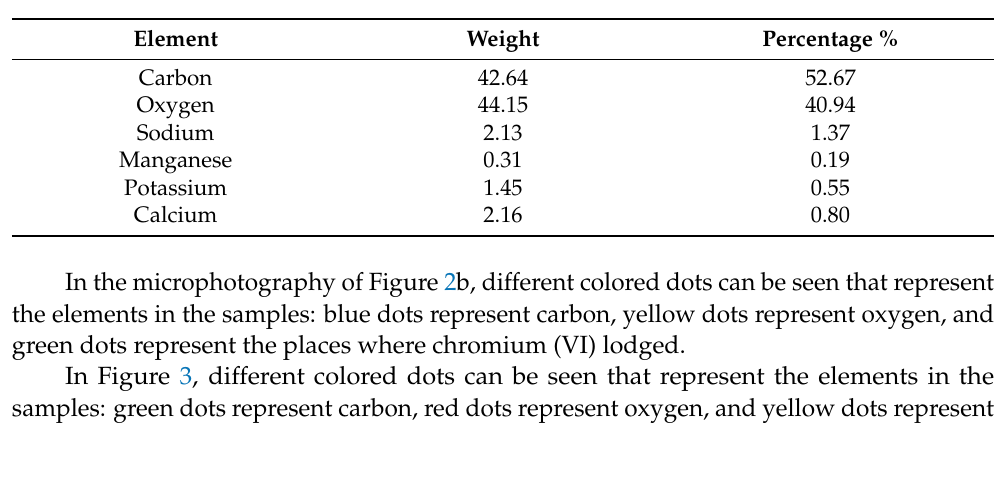
Table 2. Physicochemical characterization of the EC